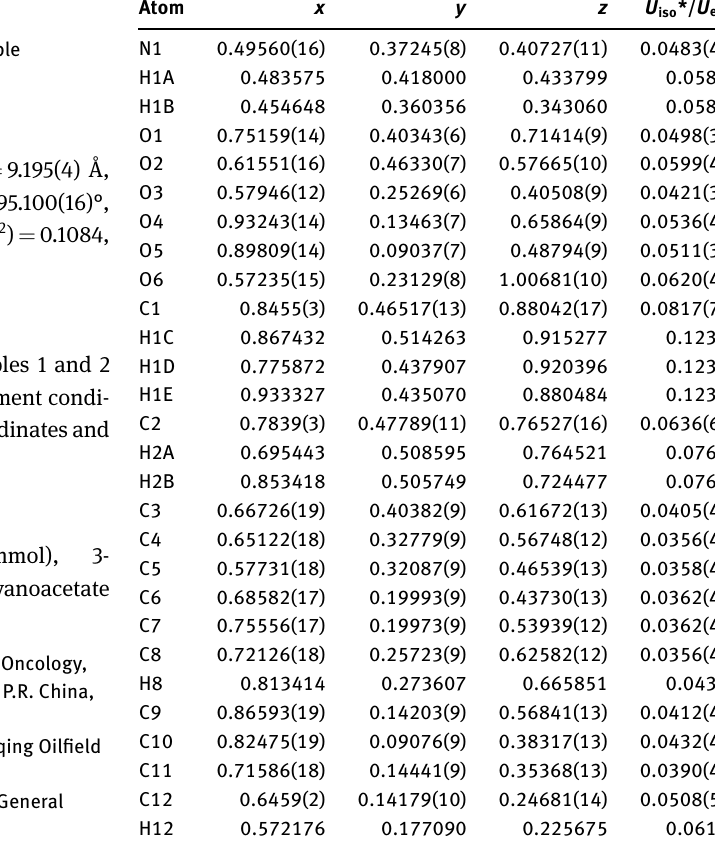
Table 2: Fractional atomic coordinates and isotropic or